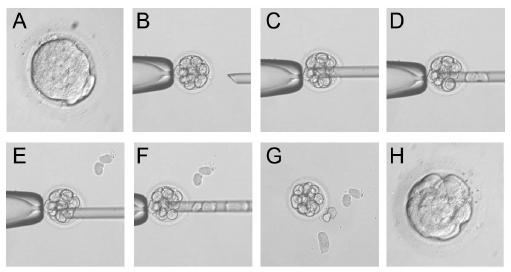
Figure 1. Biopsy of compact morula-stage embryos. ( A ) A compact morula-stage embryo before biopsy. (B–G) Steps of the biopsy. (H) An embryo at 2 h after biopsy.